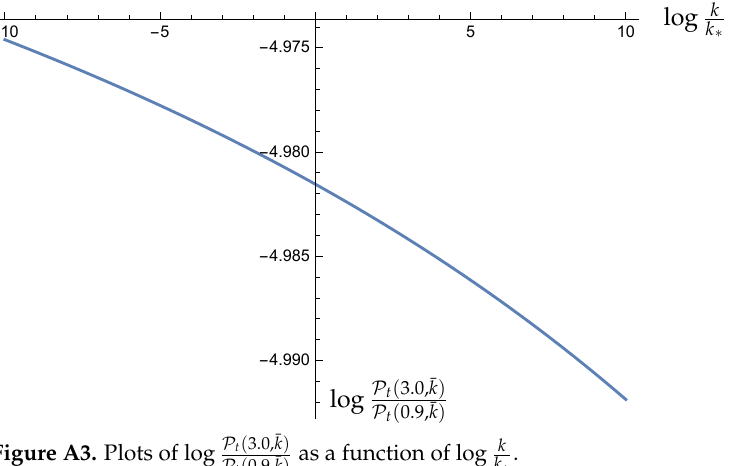
,¯ k ) with ¯ k = e − 60 (blue), e − 50 (yellow) and e − 40 (green). P t ( 0.9,¯ k )